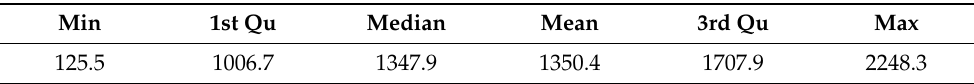
Table 2. A summary of the R l parameter in meters.